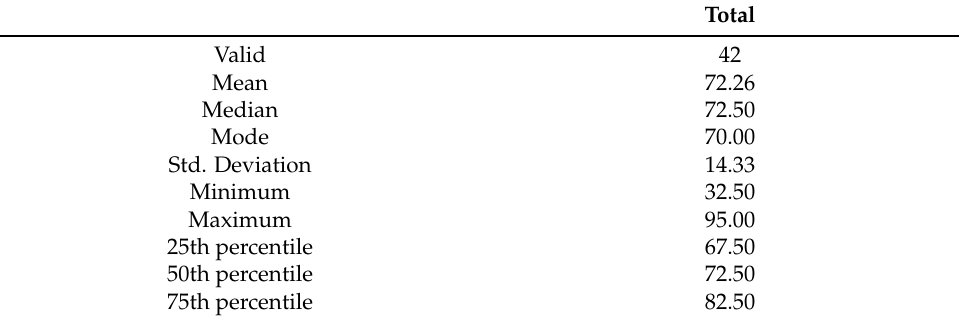
Table 6. System Usability Scale: Total overview.